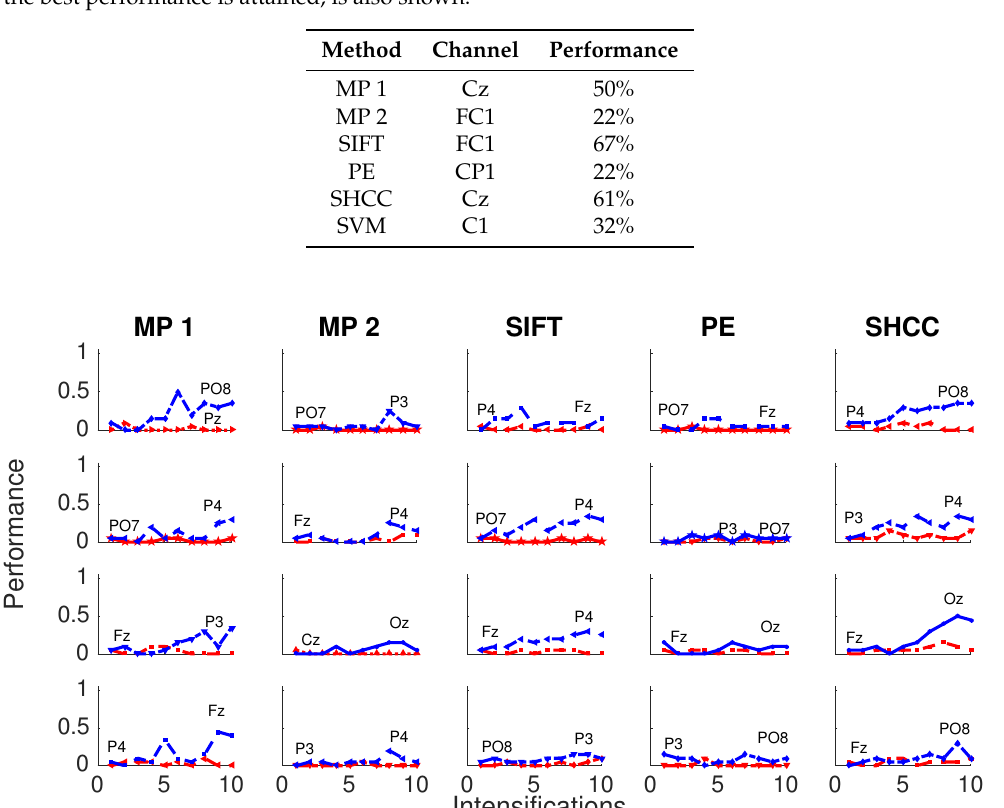
Table 2. Speller classification performance obtained for the dataset IIb of the BCI Competition II (2003) for each one of the algorithms using 15 repetitions of intensification sequences. The first 42 trials are used for training to build the template dictionary and the remaining 31 for testing. The channel where the best performance is attained, is also shown.